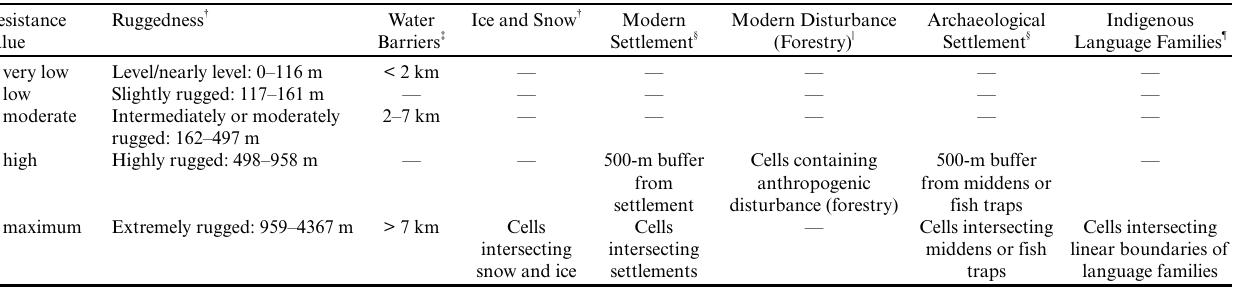
Table 1. Resistance parameterization scheme, scale of resistance values, and attributes corresponding to resistance levels 1–5 for each